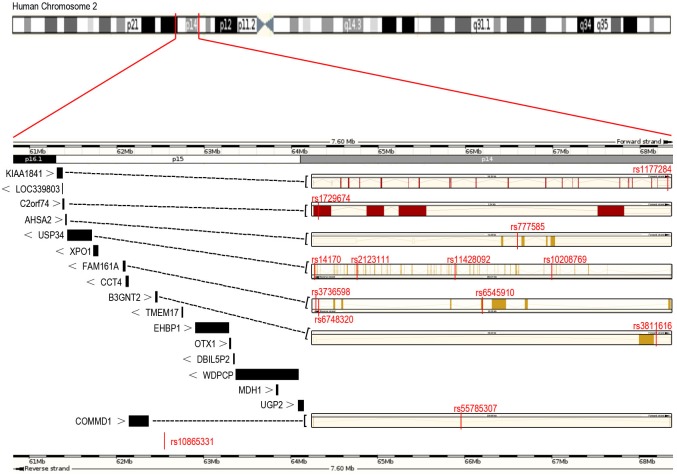
Schematic genomic structure on chromosome 2p15 region, and locations of the common single nucleotide polymorphisms (SNPs) identified in this study.